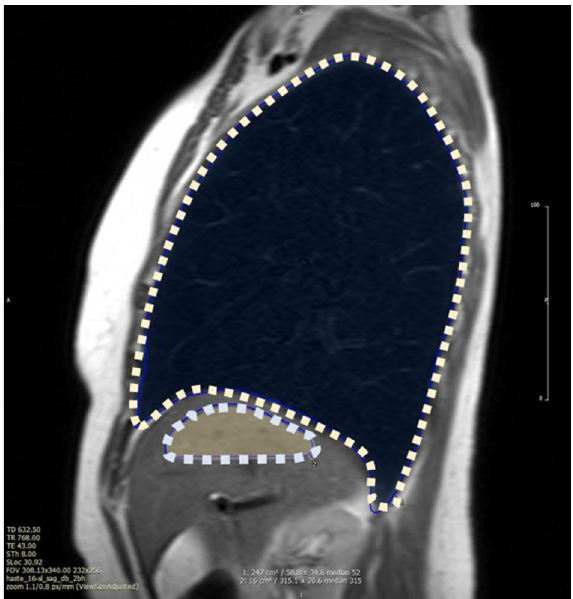
Figure 1. Simplified method for imaging Lung Water: Lung and Hepatic operator-selected region of interest (ROI) are outlined in the parasagittal plane at the larger cross-sectional lung area, usually at the right midclavicular line. Lung water density is calculated by the lung-to-liver signal ratio multiplied by